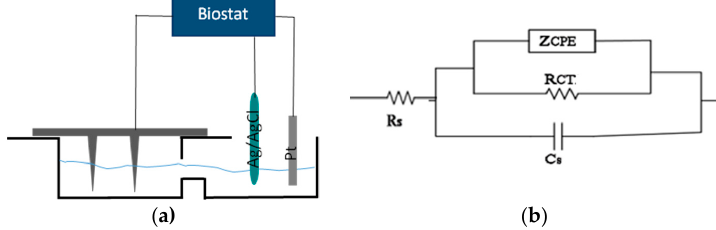
Figure 5. Electrochemical measurement setup: ( a ) MEAs measurement setup; ( b ) Equivalent circuit of the electrode-electrolyte interface.